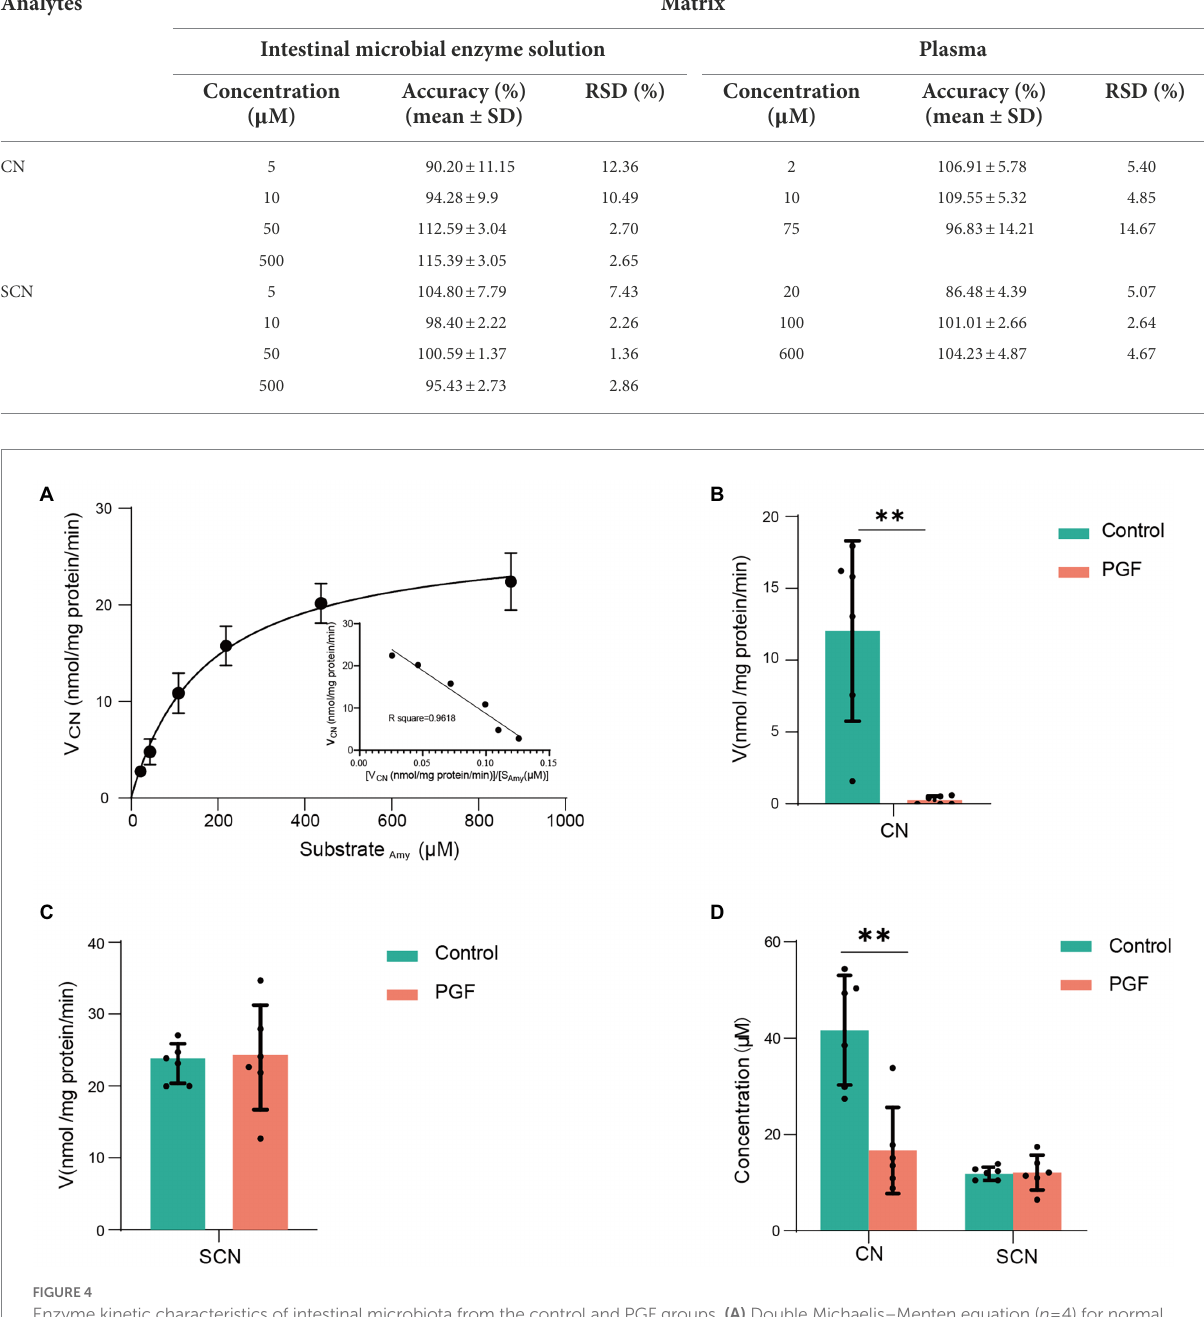
treatment. Figure 7A showed the microbial distribution in the taxa at order and family levels. Indicator taxa at order level of two groups were shown in Figure 7B. Differences between the two groups were analyzed by Linear discriminant analysis Effect Size (LEfse), and the main taxa specific to each group [Linear